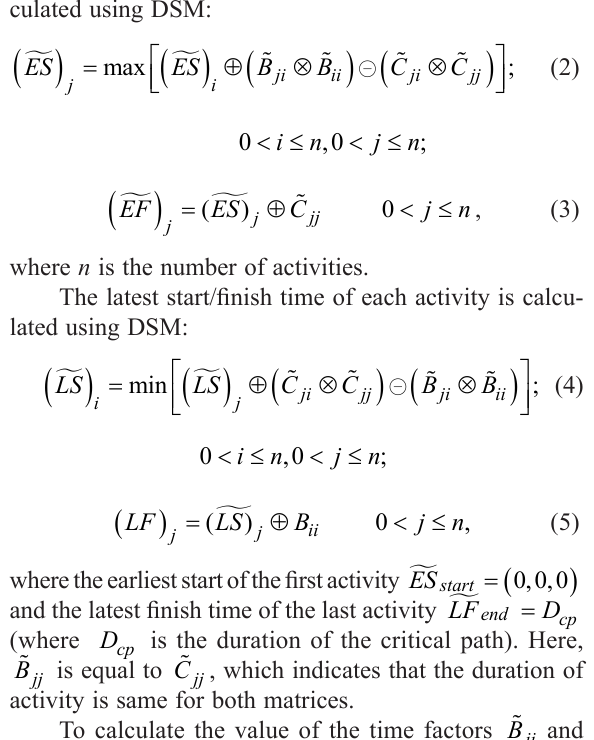
Fig. 2. Linguistic variables and triangular fuzzy numbers (Shi,